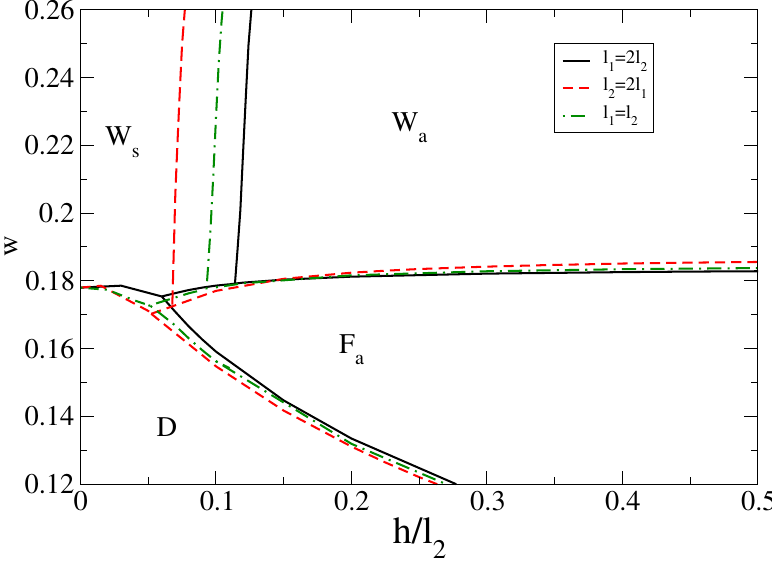
Figure 5. The same as Figure 4 for λ = 10 4